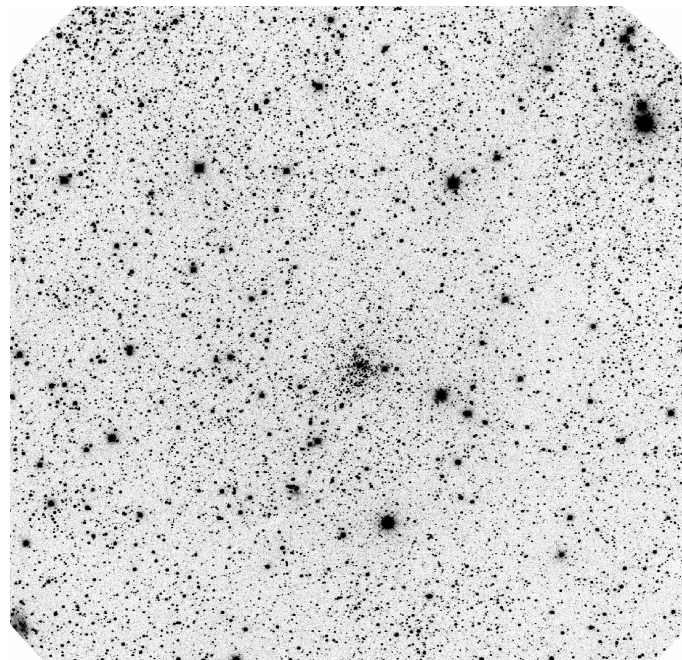
Fig. 1. Map of the observed area in the V